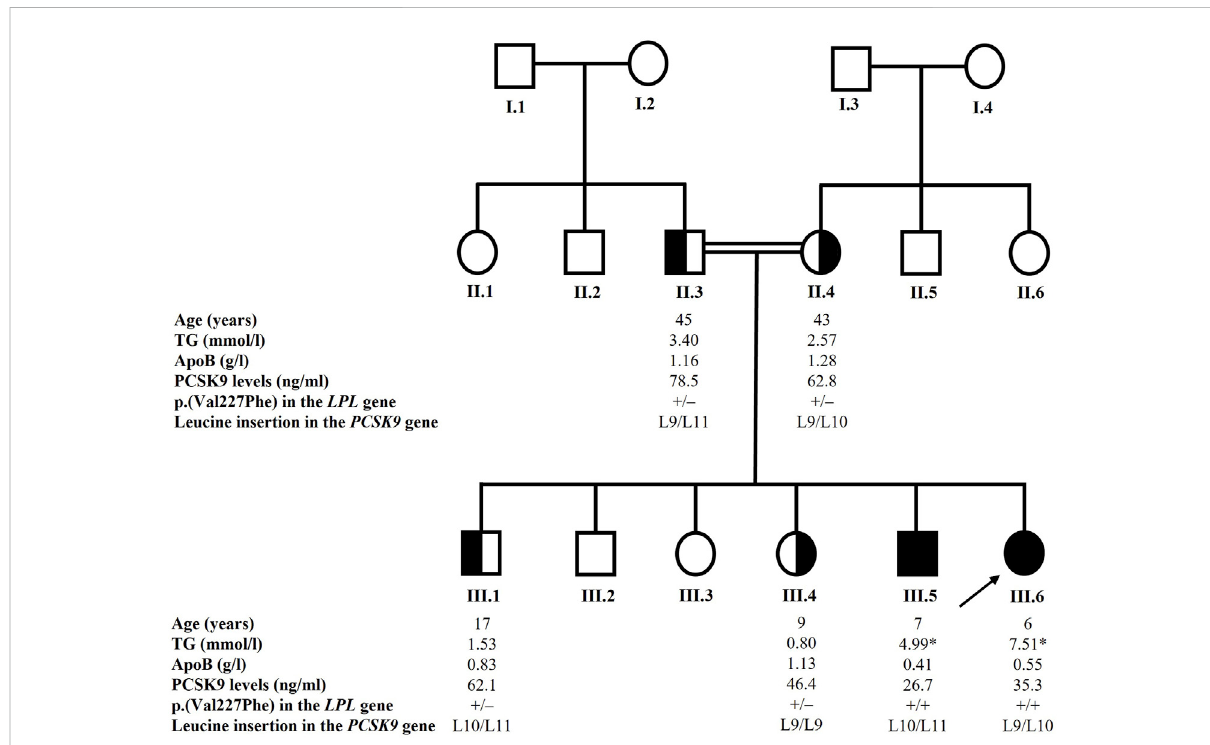
FIGURE 1 Pedigree ofthefamily.Thearrowindicatestheproband.Blackenedsymbolsindicateaffectedhomozygouscarriersofthep.(Val227Phe)variant inthe LPL gene.Half-blackenedsymbolsindicateheterozygouscarriersofthep.(Val227Phe)variant.Onlyindividualswithavailableandreporteddata were included in the study. The * sign indicates TG value while the patient was under a very strict low-fat diet. The +/+ sign indicates that the individual is homozygous for the p.(Val227Phe) variant in the LPL gene and the +/ – sign indicates that the individual is heterozygous for the variant. The L9 designates the normal allele in exon 1 of the PCSK9 gene, the L10 designates the p.Leu21dup or p.L15_L16insL and the L11 variant designates the p.Leu21tri or p.L15_L16ins2L. Age at recruitment is given in years. TG levels are given in mmol/l, ApoB levels are given in g/l and PCSK9 levels are given in ng/ml. ApoB: apolipoprotein B; LPL: lipoprotein lipase; PCSK9: proprotein convertase subtilisin/kexin type 9; TG: